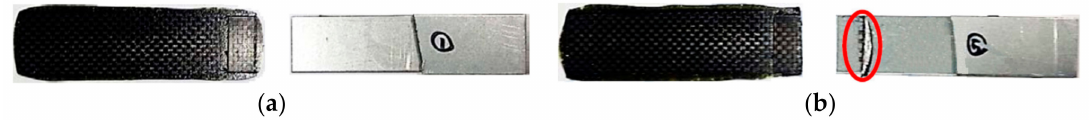
Figure 9. Specimens after the shear lap adhesion test (bonding pressure: 1.0 MPa): ( a ) without sandblast treatment; ( b ) with surface roughness (Rz = 45 µ